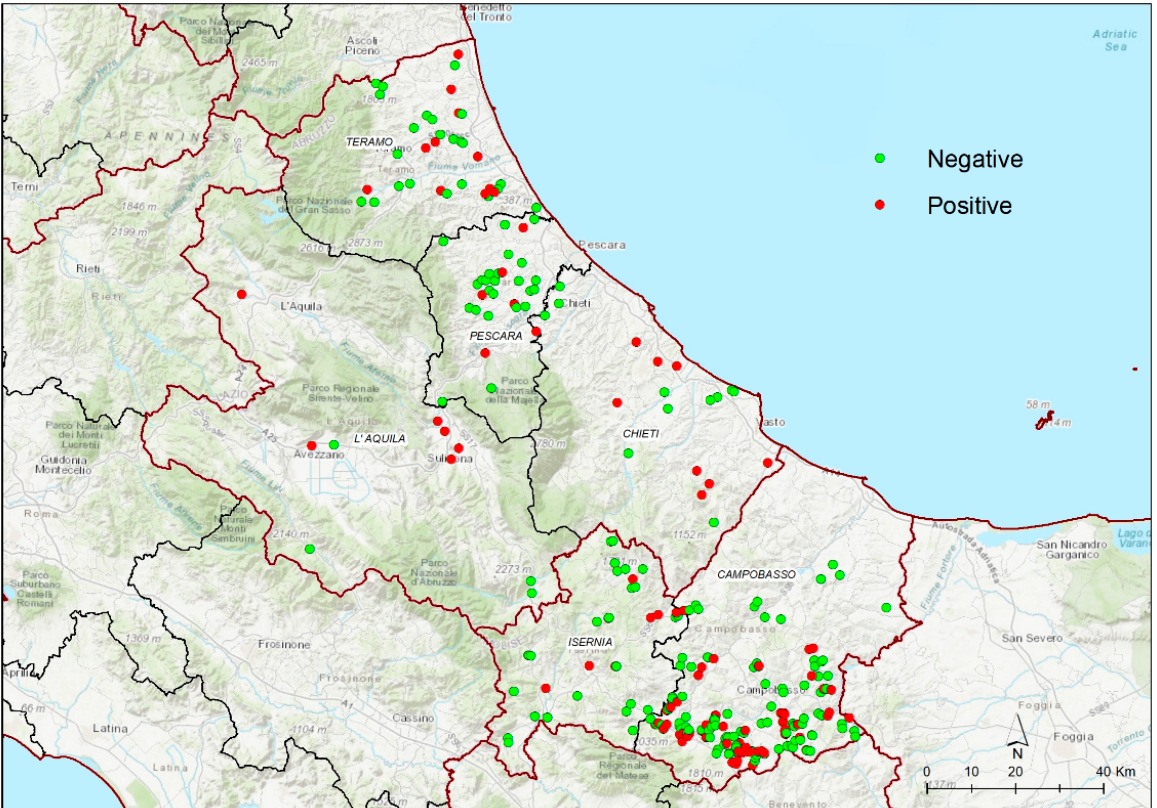
Figure 1. Map of central Italy showing locations of poultry farms tested for Salmonella spp. in Abruzzo and Molise Regions between 2015 and 2020. Red dots represent farms where Salmonella spp. was detected at least once over the study period; green dots represent farms where Salmonella spp. was never detected. Each farm could incorporate more than one type of flock. Table 2. Yearly percentages of samples resulted positive to isolation of Salmonella